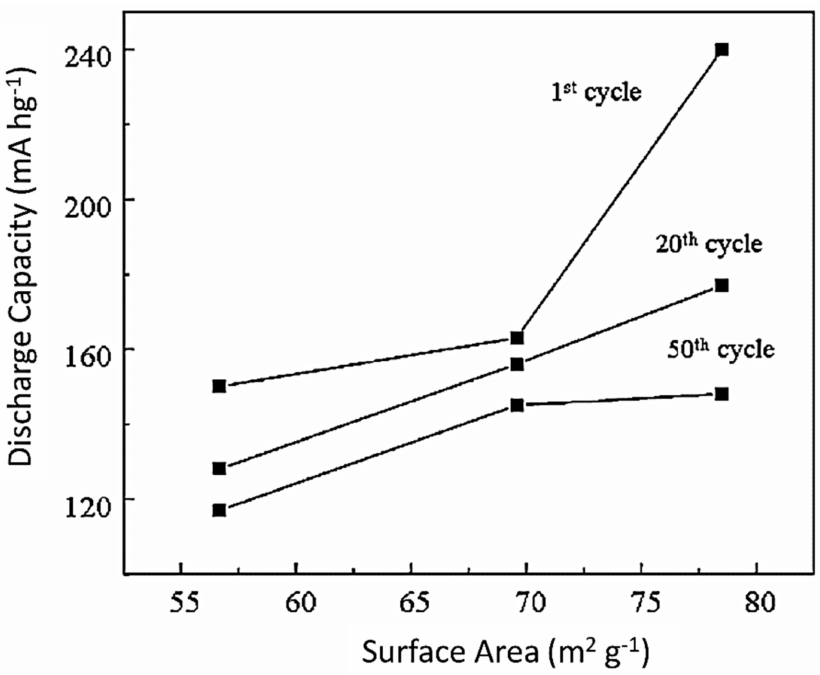
Figure 17. A study of the discharge capacities of anatase TiO 2 nanotube arrays annealed for three hours at 300 ◦ C, 400 ◦ C, and 500 ◦ C in nitrogen, based on the specific surface areas of the nanotubes. Reprinted with permission from Ref. [187]. Copyright 2010